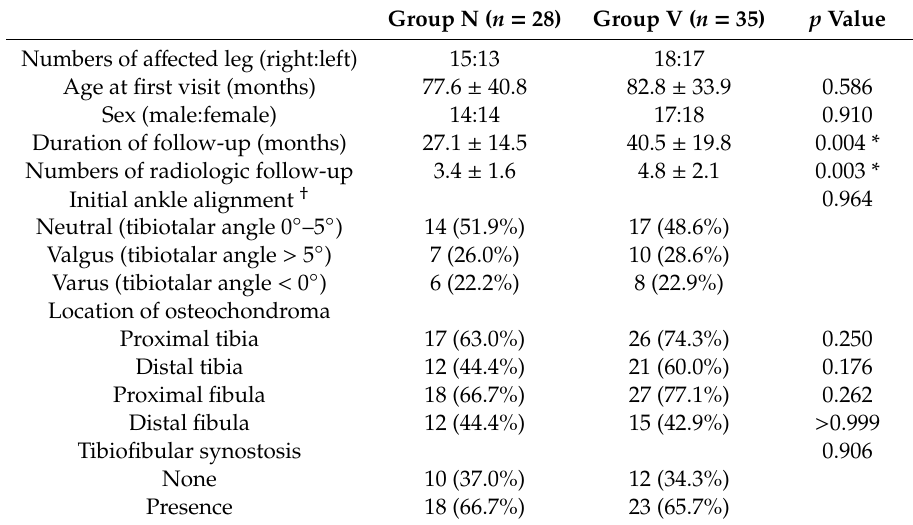
Table 1. Summary of the